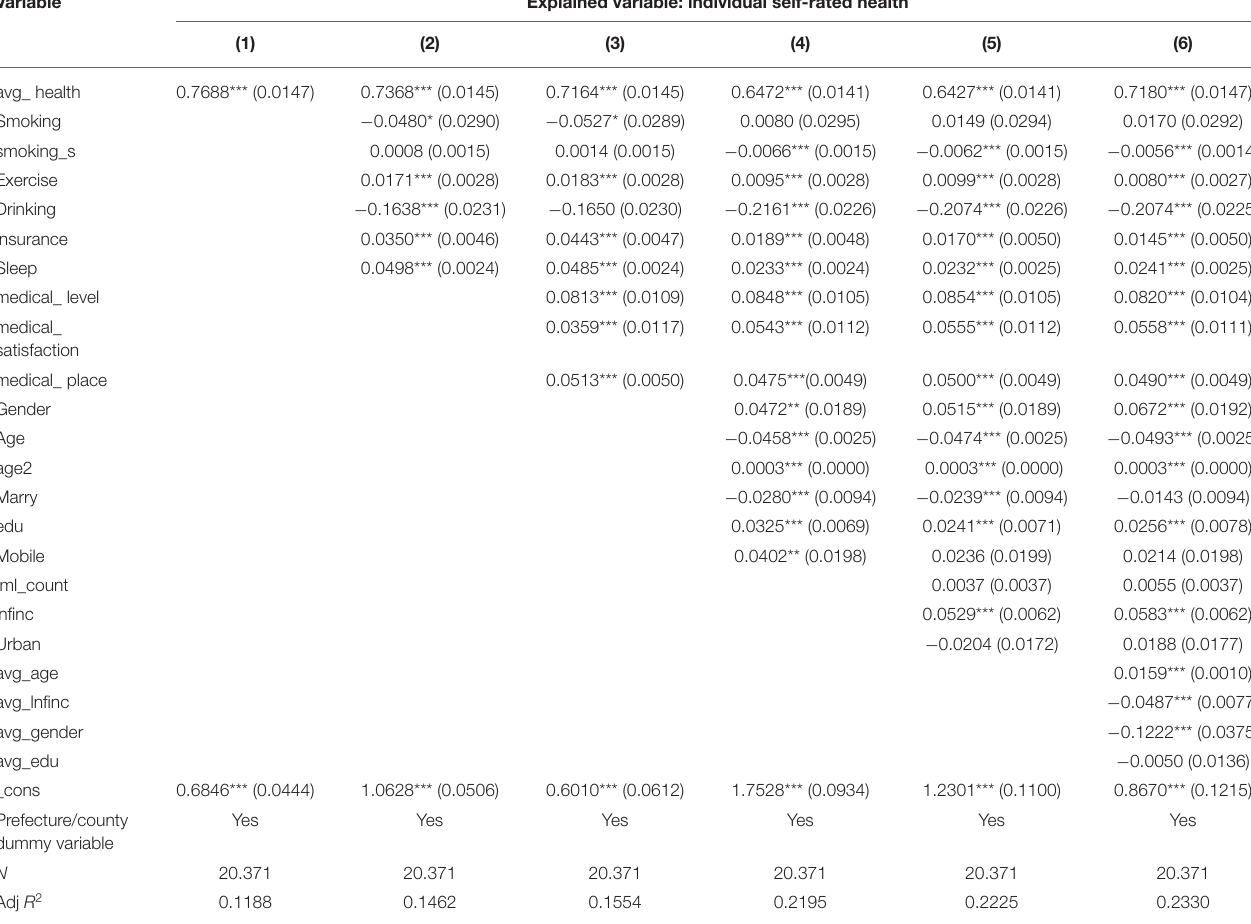
TABLE 2 | OLS regression results. Variable Explained variable: individual self-rated